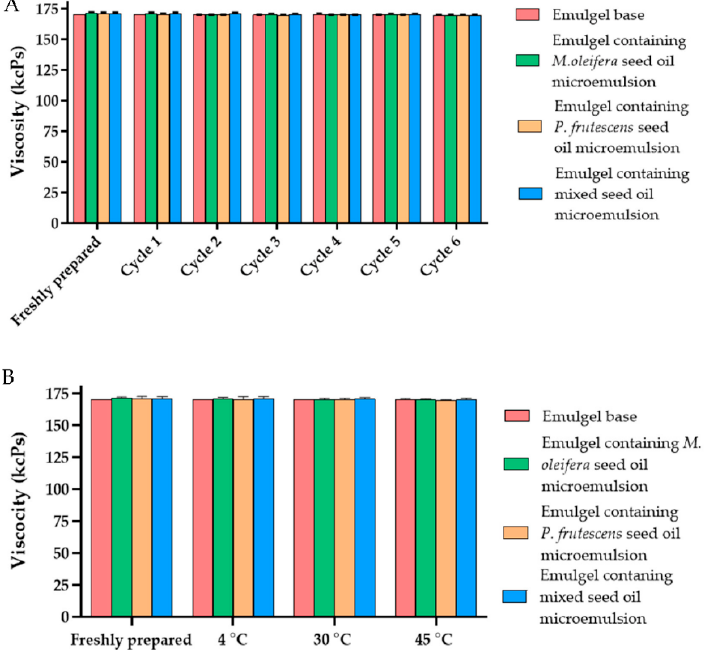
Figure 7. ( A ) Effects of six heating–cooling cycle stability tests on the viscosity of emulgel base and emulgels containing P. frutescens , M. oleifera , and mixed seed oil microemulsion. ( B ) Effect of temperature on the viscosity of gel base and emulgels containing P. frutescens , M. oleifera , and mixed seed oil microemulsion after storage at 4 °C, 30 °C, and 45 °C for 1 month. Data represent mean ± SD from three experiments.